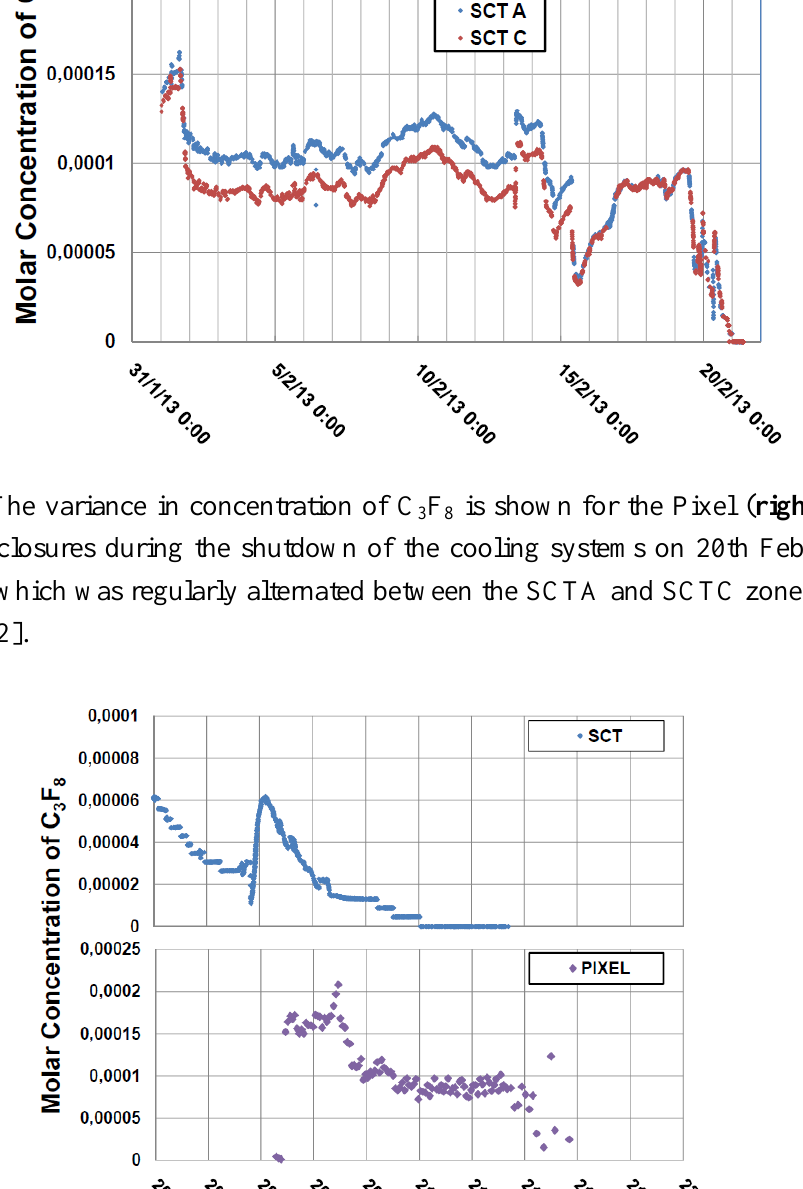
Figure 12. The variance in concentration of C time (between 1st and 21st February) is shown for the two zones analyzed, designated SCTA and SCTC [12].